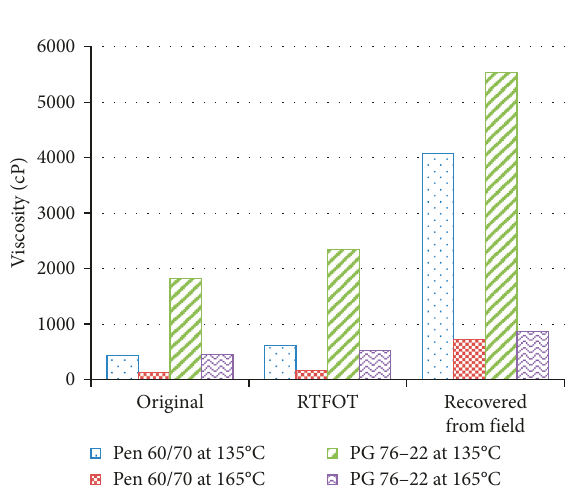
Figure 3: Effect of long-term aging duration on dynamic modulus [40].